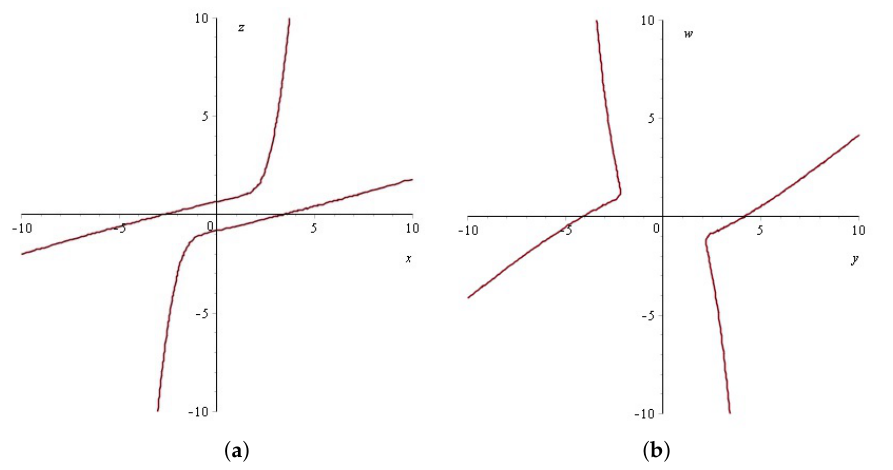
Figure 1. Henneberg algebraic curves. ( a ): γ 4,2 ( x , z ) = 0; ( b ): γ 4,2 ( y , w ) =